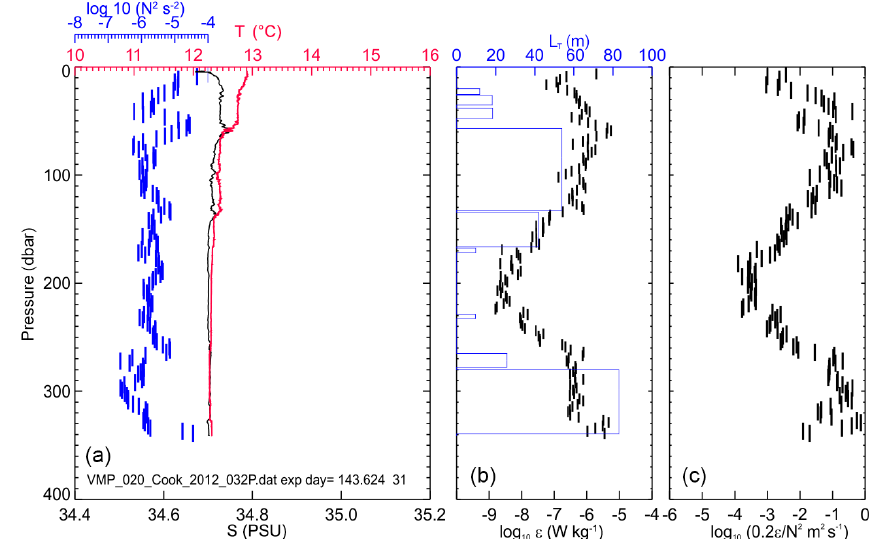
Figure 9. Profile C from day 143, 2012, showing (a) temperature, salinity and buoyancy frequency squared ( N 2 ); (b) L T and ε ; and (c) proxy for vertical diffusivity 0.2 ε/N 2 . Note the profile extends over the full depth of the water column.